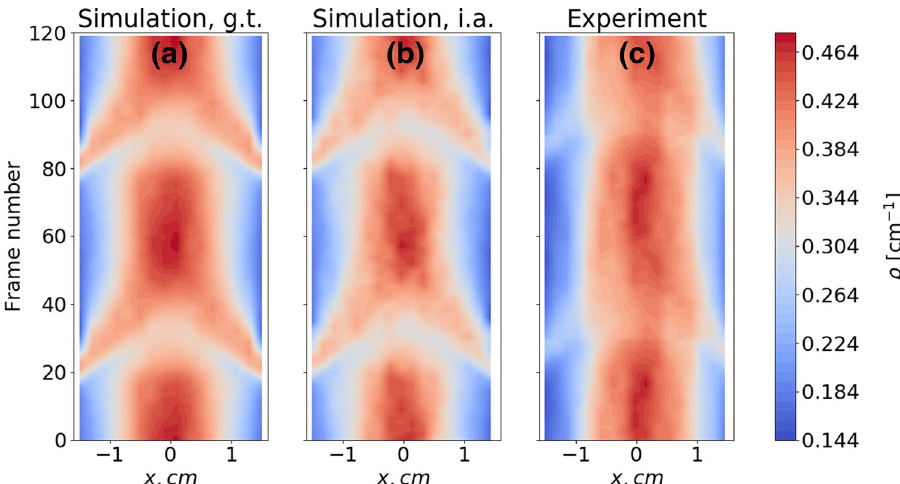
367 rods, the filling fraction is φ 2.0 % . ( a ) Ground truth Figure 4. Normalized density profiles for N = = from the simulation, ( b ) reconstruction from the synthetic images of simulated data, ( c ) reconstruction using the experimental videos from one of the parabolic flight experiments. Data were obtained by synchronous sampling across 100 periods in the simulation and 50 periods in the